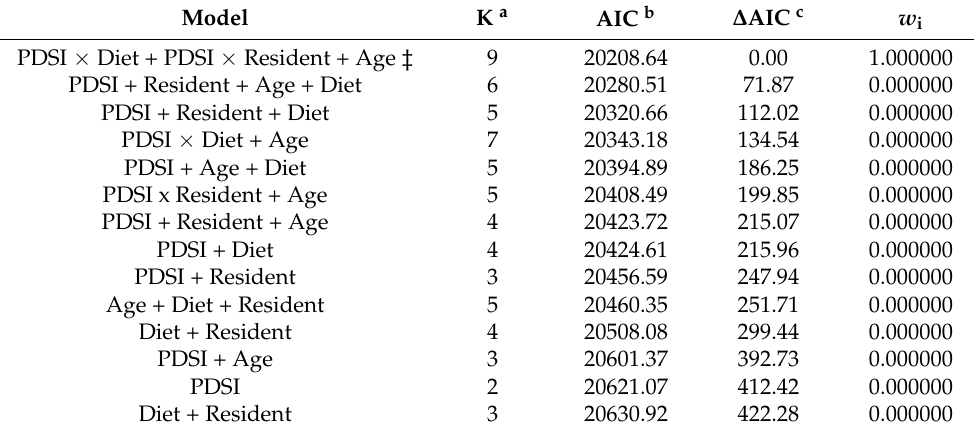
Table 2. Model selection results of logistic regression models for estimating fat score in relation to Palmer Drought Severity Index (PDSI) from New Mexico region 2 climate division, diet classification (insectivore, granivore, and omnivore), residency (migrant versus year-round resident) and age (hatch year versus after hatch year); data collected from 2010 to 2020. Model selection based on Akaike’s Information Criterion (AIC), and difference in AIC between each model compared to the model with the lowest AIC ( ∆ AIC). Model K a AIC b ∆ AIC c w i PDSI × Diet + PDSI × Resident + Age